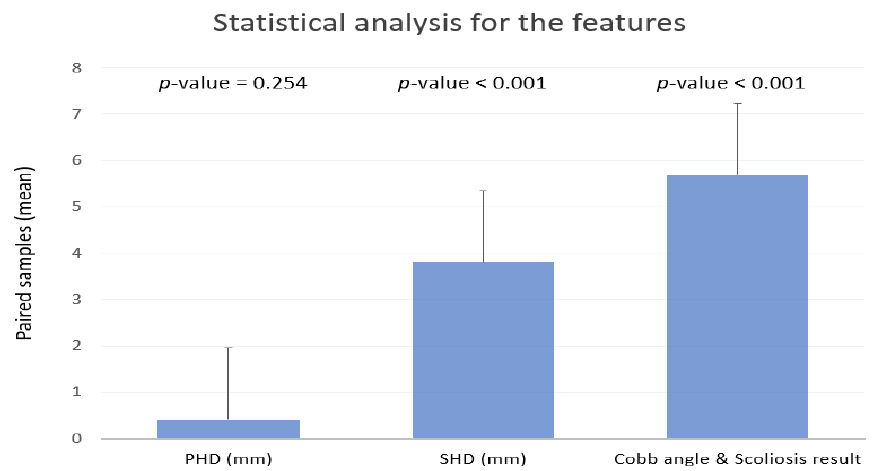
Figure 3. Statistical analysis of the pelvic height difference, shoulder height difference, and scoliosis results between radiographic analysis and computer vision-based posture analysis using paired t-test.